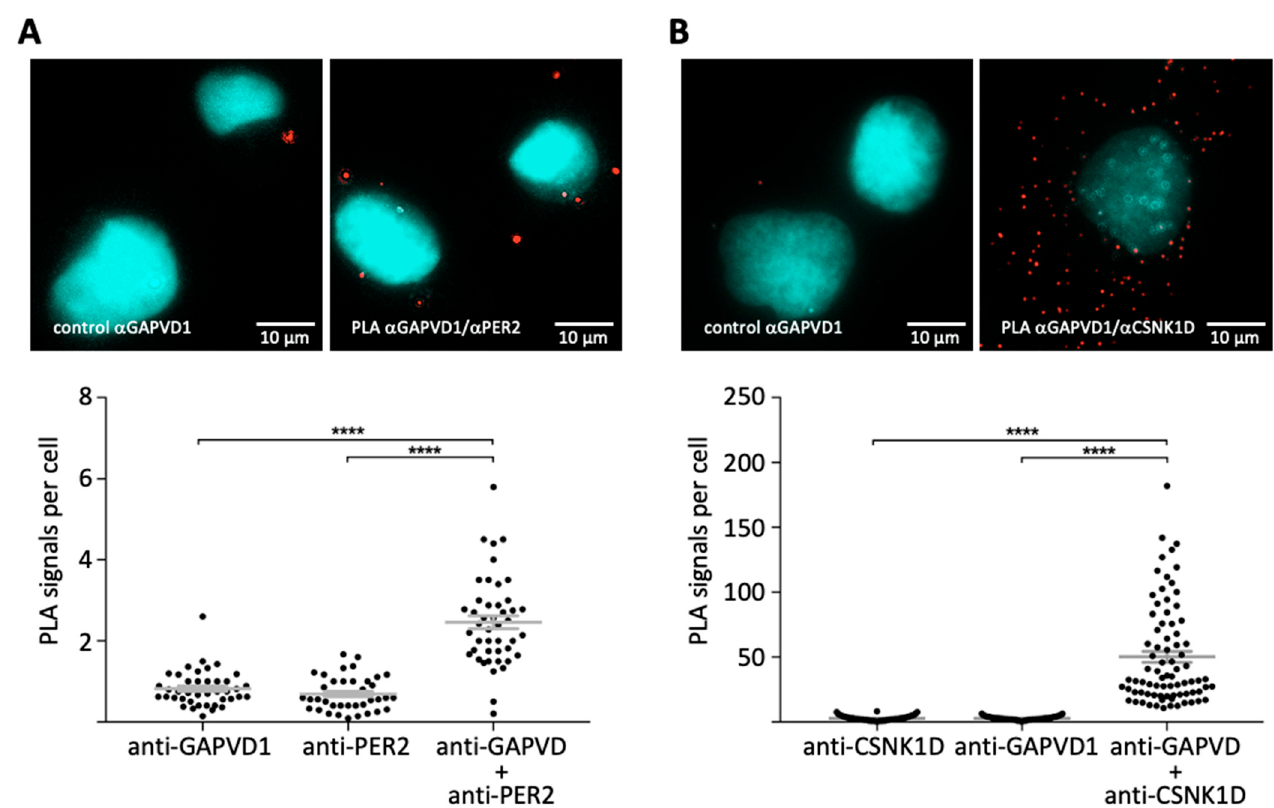
Figure 2. In situ detection of GTPase-activating protein and VPS9 domain-containing protein 1 (GAPVD1)-PER2 and GAPVD1-casein kinase 1 delta (CSNK1D) protein complexes by proximity ligation assay (PLA). ( A ) Immunofluorescence microscopy overlay images of PLA with primary antibodies against GAPVD1 and PER2 or ( B ) GAPVD1 and CSNK1D in wild type HT1080 cells. Red: PLA signals; cyan: DAPI. Lower panels: Quantification of PLA, including controls with only one primary antibody each. Data points represent single cells on at least five different microscopy slides in three independent experiments; **** p < 5 × 10 − 5 ( t -test).